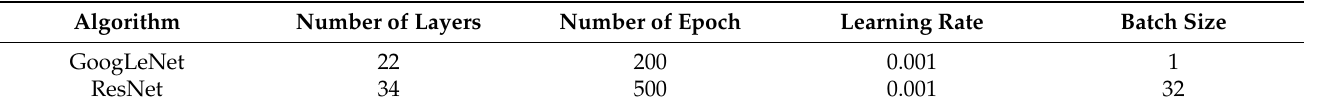
Table 1. Parameters used for Benchmark.